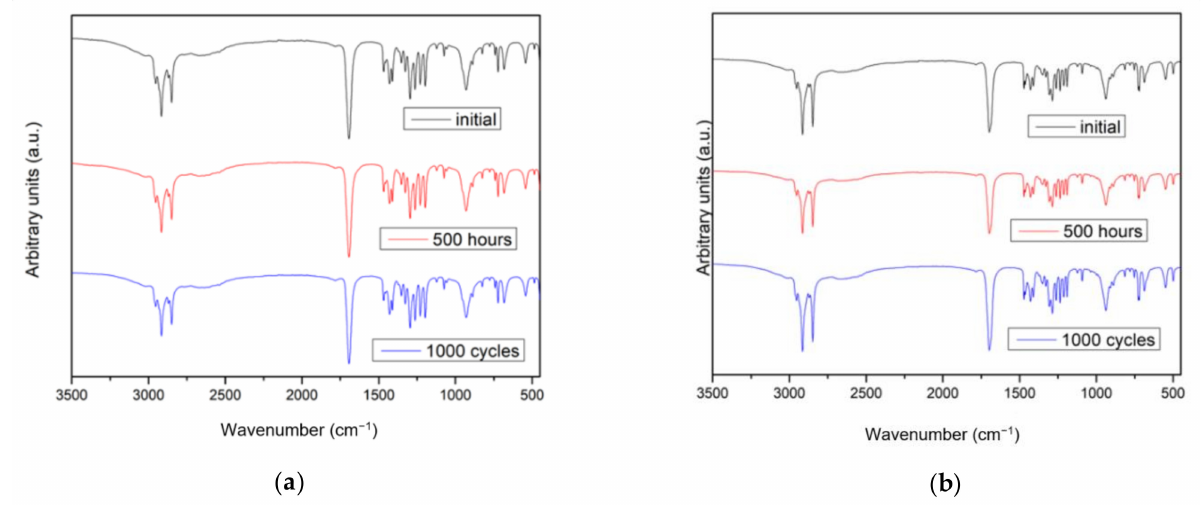
Figure 1. FT-IR results: ( a ) capric acid samples: initial, thermal degradation 500 h, and thermal cycling 1000 cycles ( b ) myristic acid: initial, thermal degradation 500 h, and thermal cycling 1000 cycles.